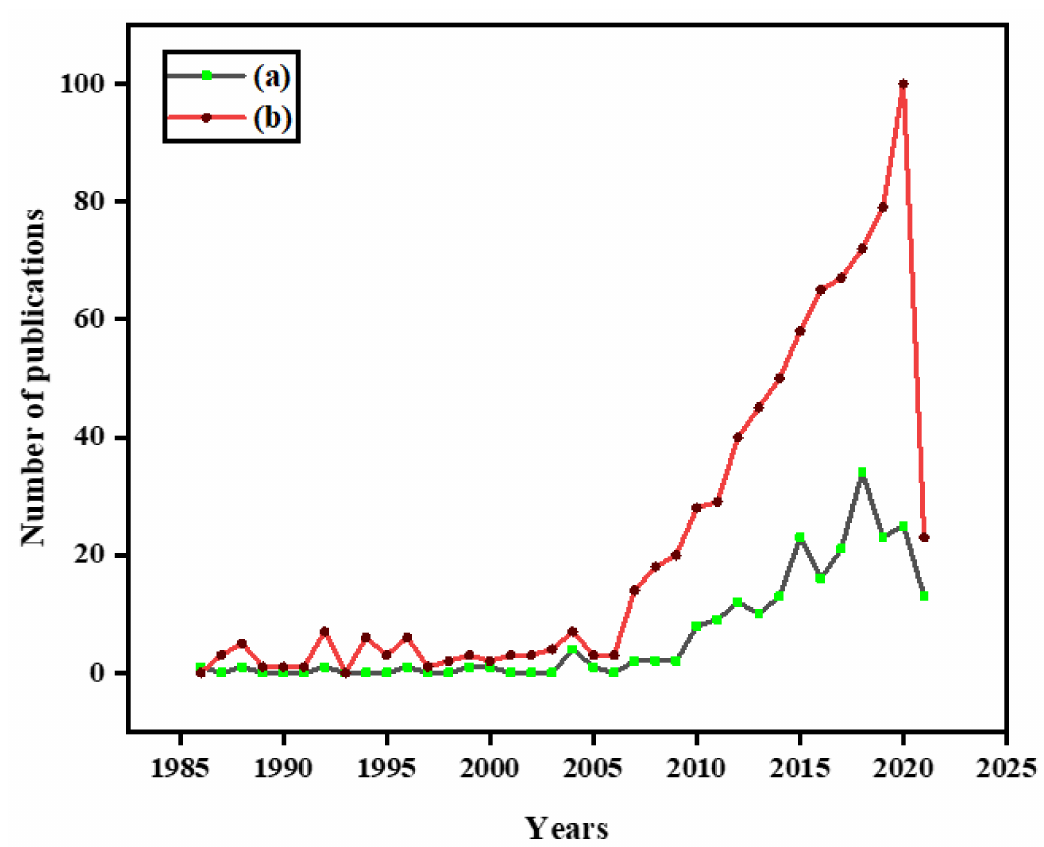
Figure 1. Research publication status, an analysis of yearly publication: ( a ) lignocellulolytic bacteria; ( b ) lignocellulose degradation by